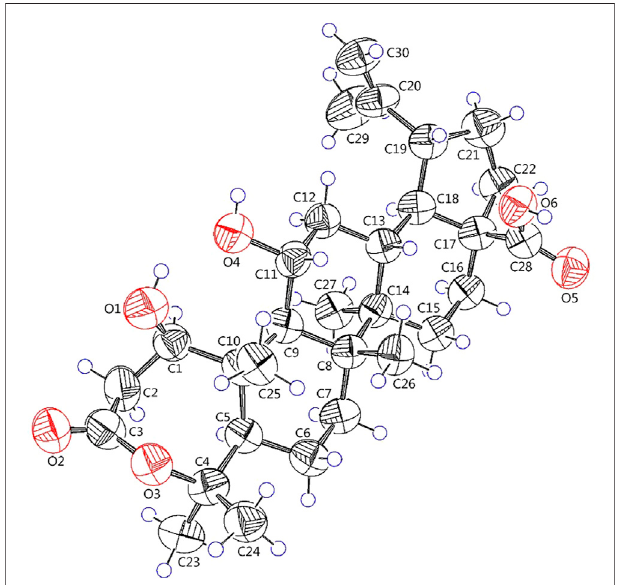
FIGURE 4 | X-ray crystallographic structure of 1 .